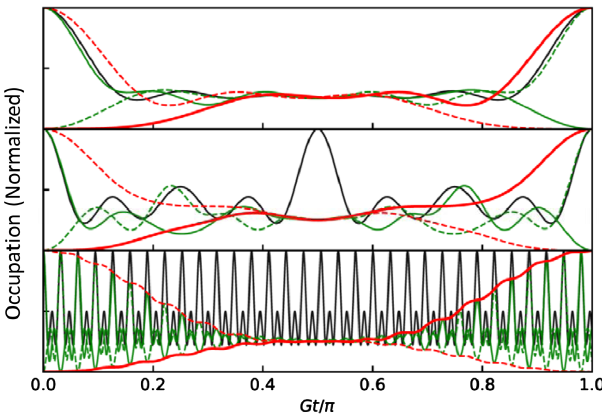
FIG. 8. Time evolution of the mechanical and spin-ensemble systems under a constant spin-mechanical coupling. At t ¼ 0 , the ˆ ˆ ˆ S 1 , ˆ a 1 , and b is 1 and that in S 2 and ˆ a 2 is 0. Red occupation in lines: two spin ensembles. Green lines: two resonator modes. Black line: the waveguide mode. Top panel: Γ =G ¼ 2 . Middle ffiffiffiffiffiffiffiffiffiffi p 1001 panel: Γ =G ¼ 4 . Bottom panel: Γ =G ¼ . For both the top and middle panels, the complete state swap between the spin ensembles is accompanied by that between the resonator